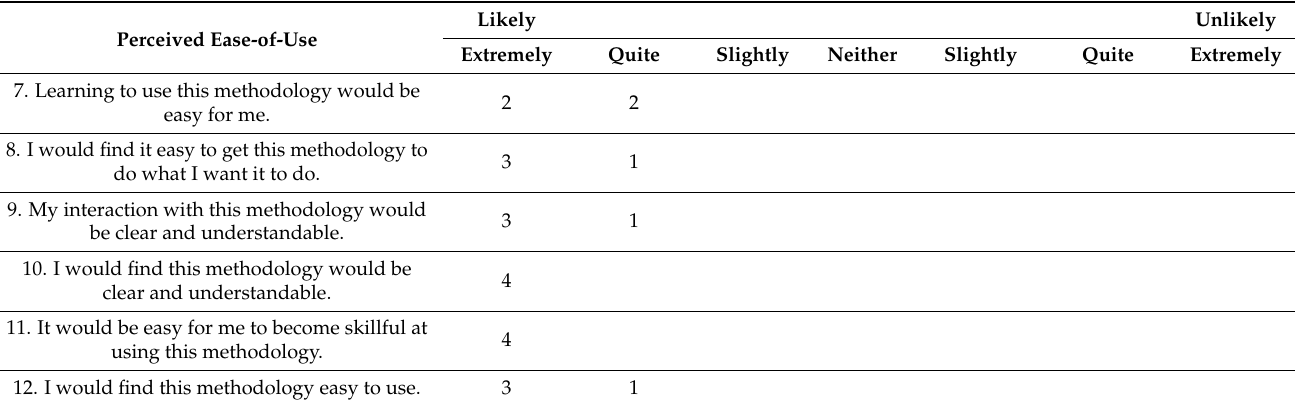
Table 11. Technology Acceptance Model Perceived